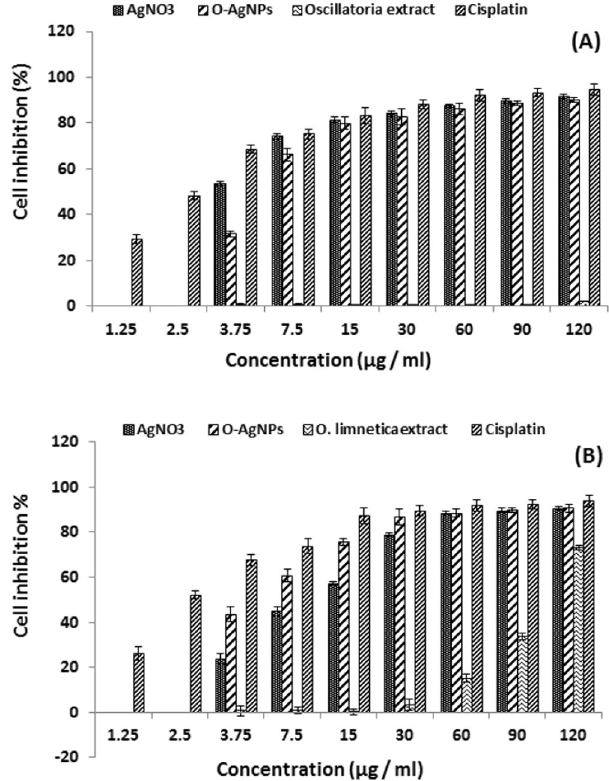
Figure 10. Cytotoxicity of O-AgNPs on human breast cancer cell line (M CF-7) ( A ) and colon cancer cell line (HCT-116) ( B